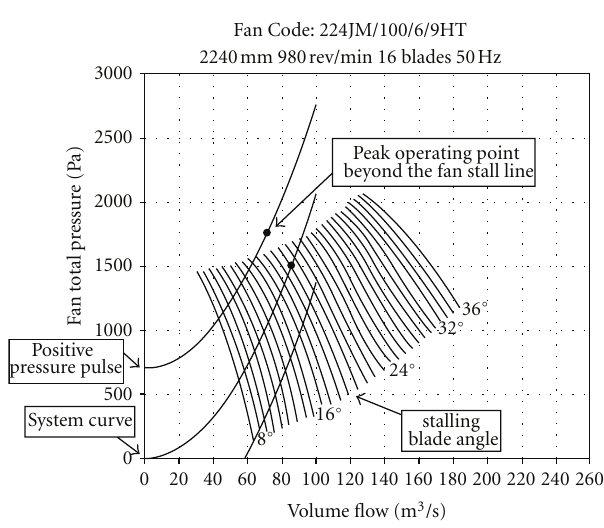
Figure 10: Optimum fan selections for a common duty point, fan selection strategy three: stabilisation